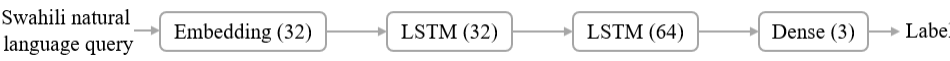
Figure 3. Deep learning model for processing Swahili natural language